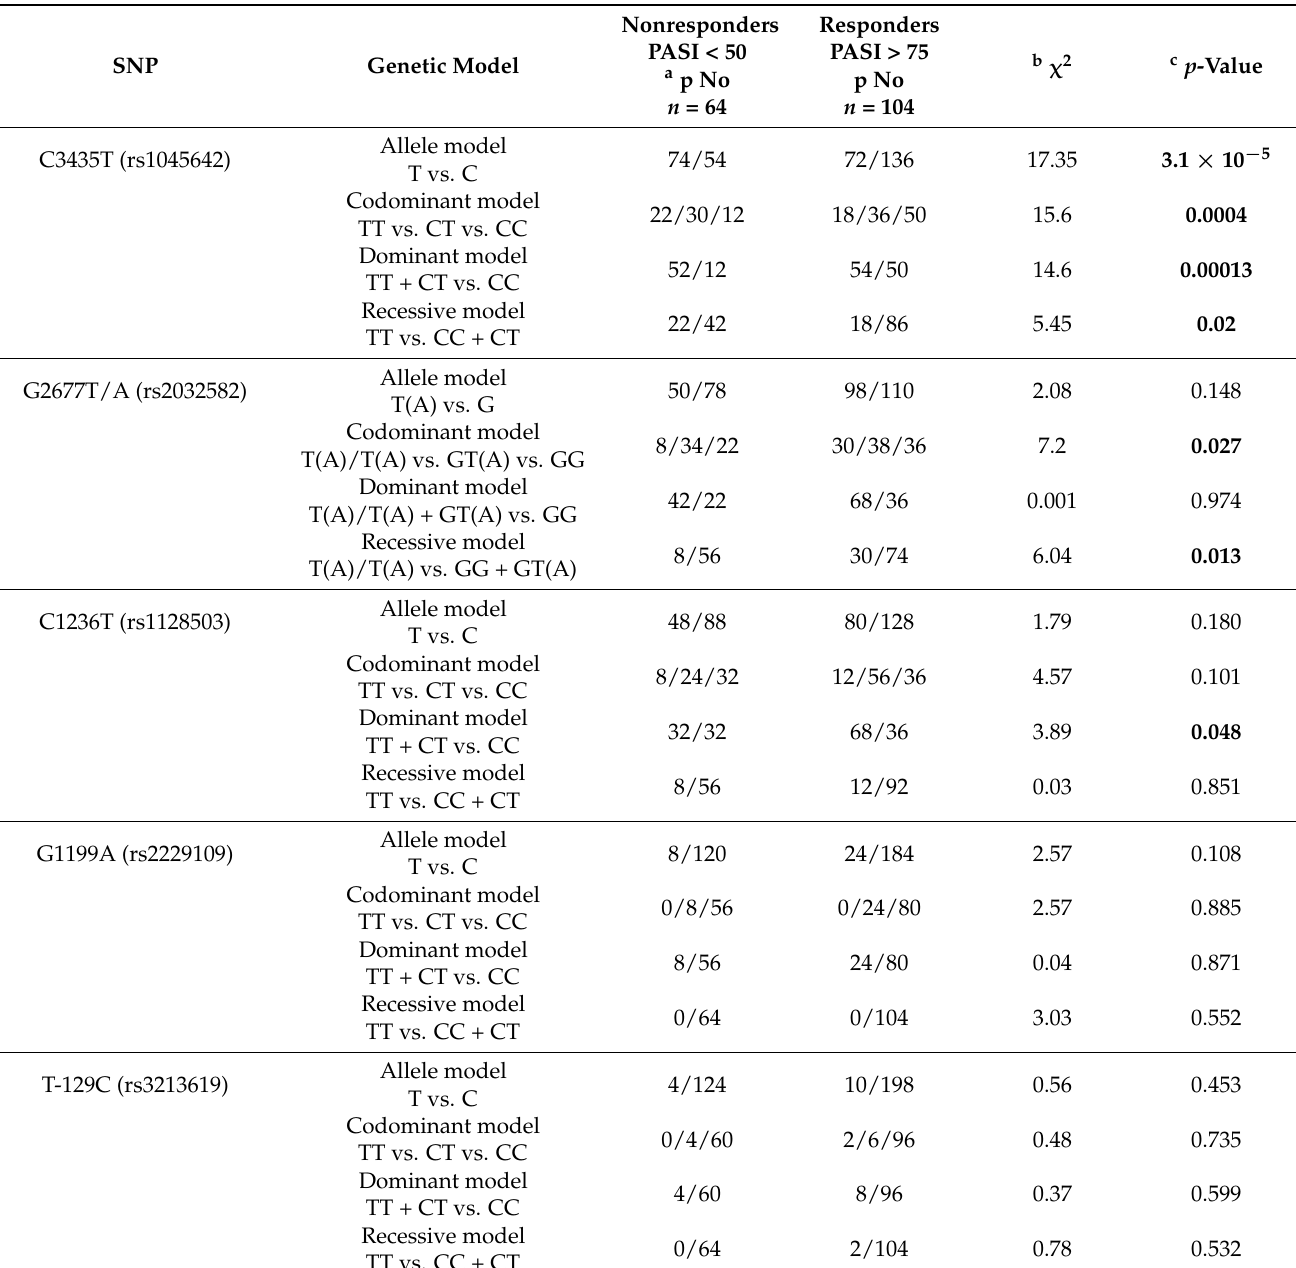
Table 4. Association analysis of SNPs from ABCB1 gene with response to cyclosporine therapy at 3